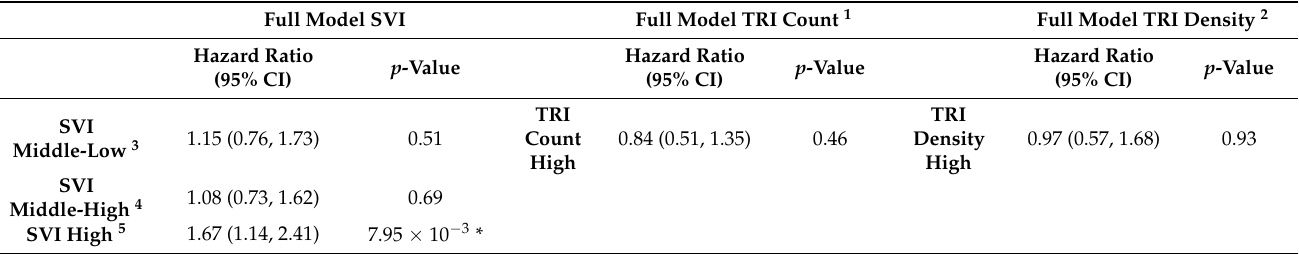
Table 3. Overall Deaths Multivariable Analysis with Categorical